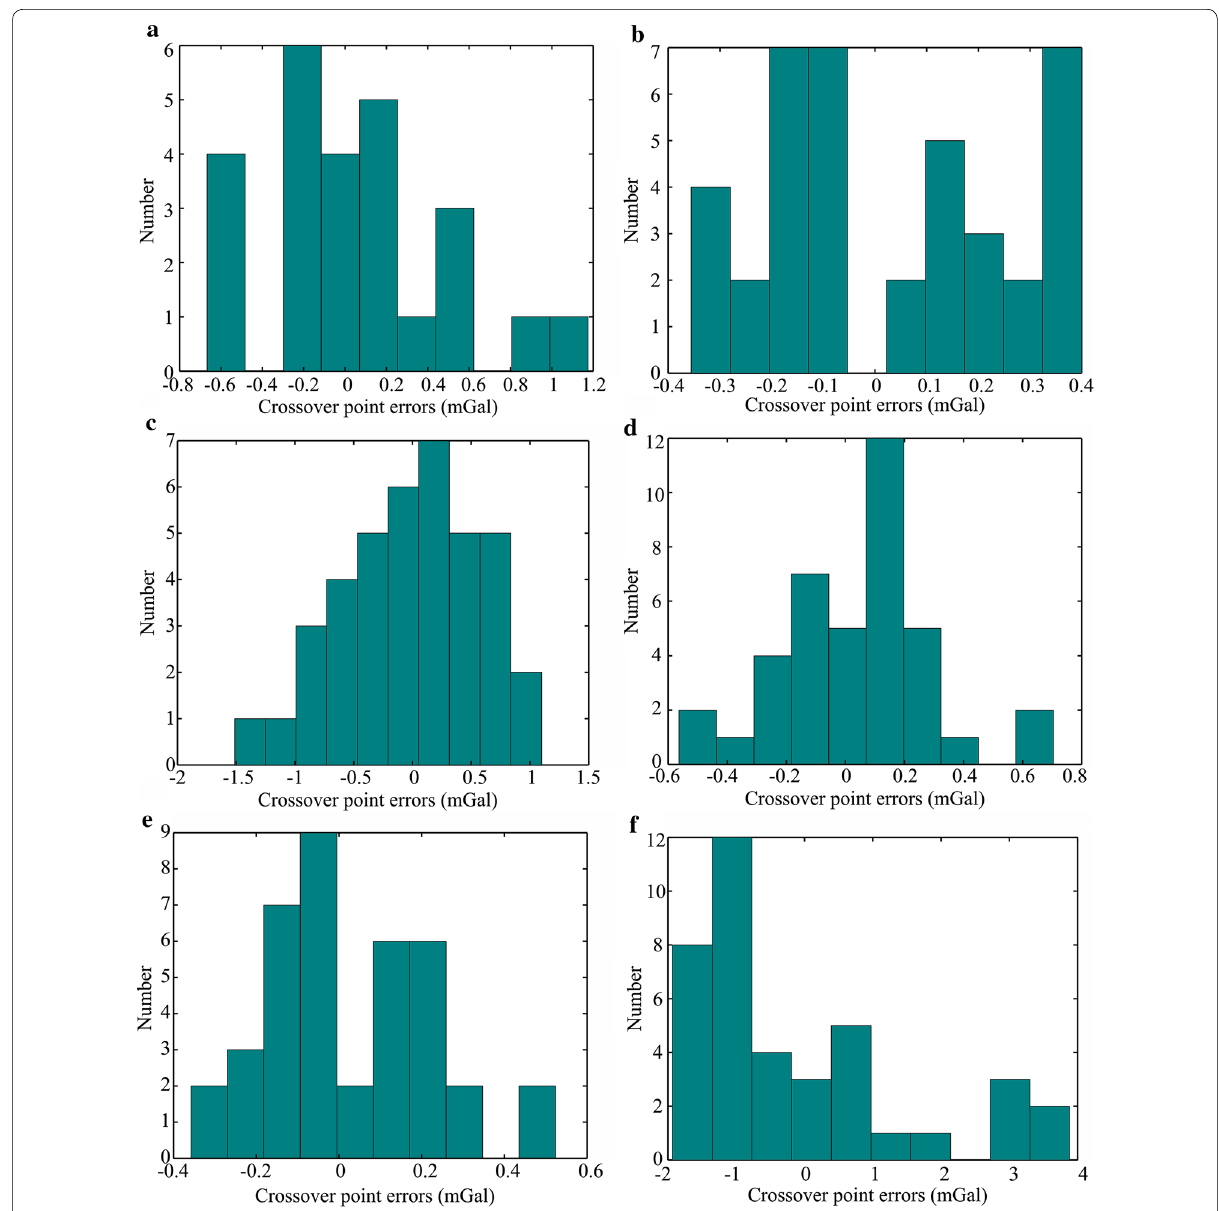
Fig. 7 Crossover point errors distribution for the different gravimeters: a CHZ-II; b SAG-2M; c SGA-WZ; d ZL11; e GT-2M; f